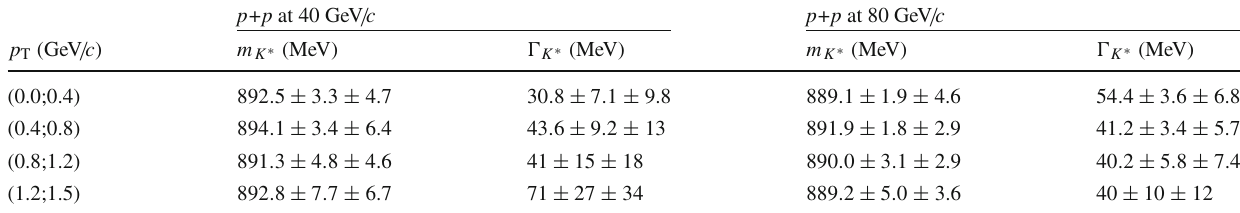
Table 4 The numerical values of mass and width of K ∗ ( 892 ) 0 mesons fitted in 0 < y < 1 . 5 and presented in Fig. 5. The first uncertainty is statistical, while the second one is systematic